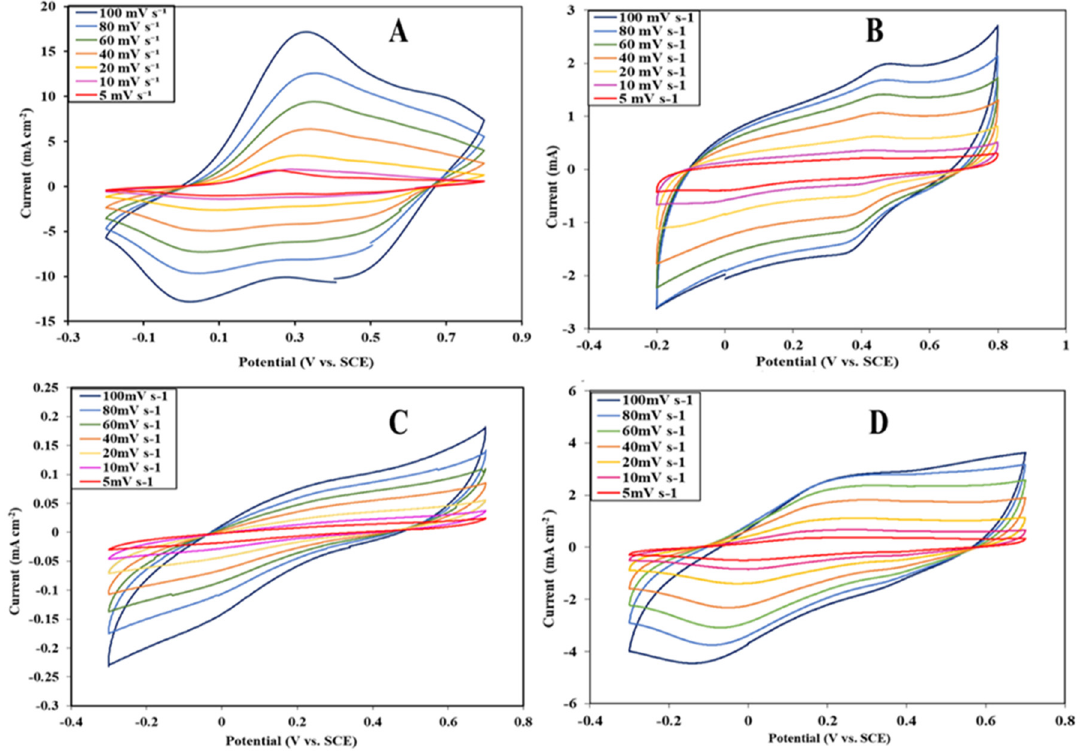
Figure 3. CV plots of ( A ) PANI, ( B ) rGO, ( C ) α -MnO 2 /PANI and ( D ) α -MnO 2 /PANI/rGO.